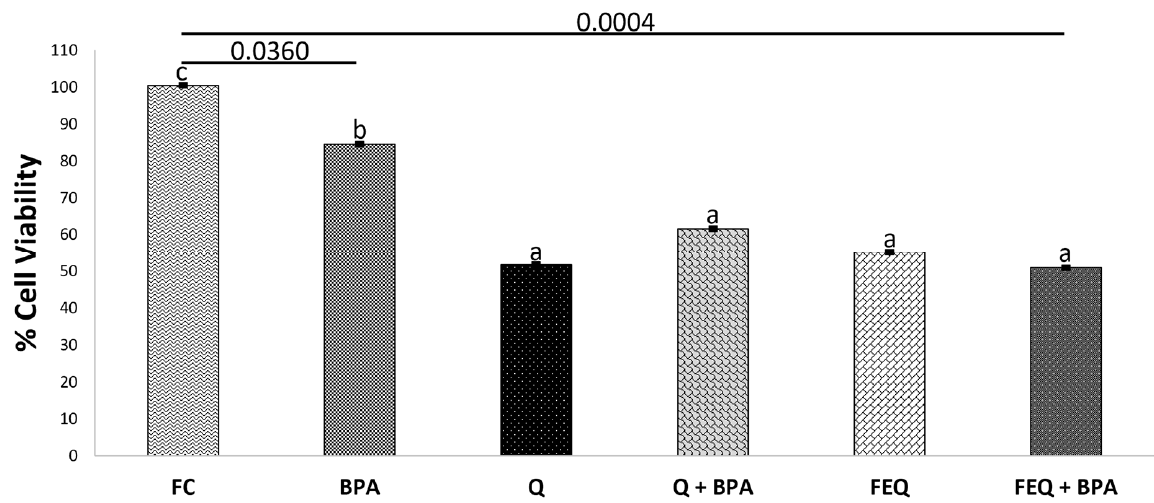
Figure 4. Effect of quercetin and FEQ on HT-29 colon cancer cells treated with BPA. Concentration of treatments: Q 160 µ M, BPA 4.4 µ M, FEQ 16%. FC: fermentation control. Each value represents the average of three independent experiments in triplicate ± ES, of cells treated with quercetin or FEQ after 48 h. Different letters per column indicate significant difference ( p < 0.05) by Tukey’s test. The treated cells were normalized with the negative control.